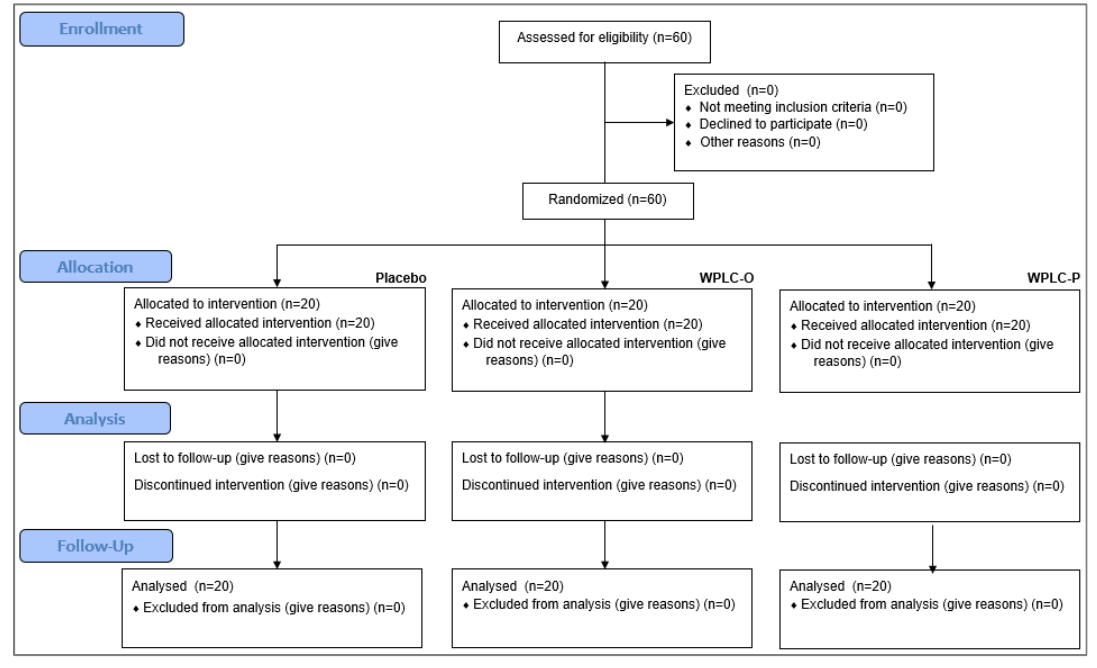
Figure 2. Study participant flow chart.